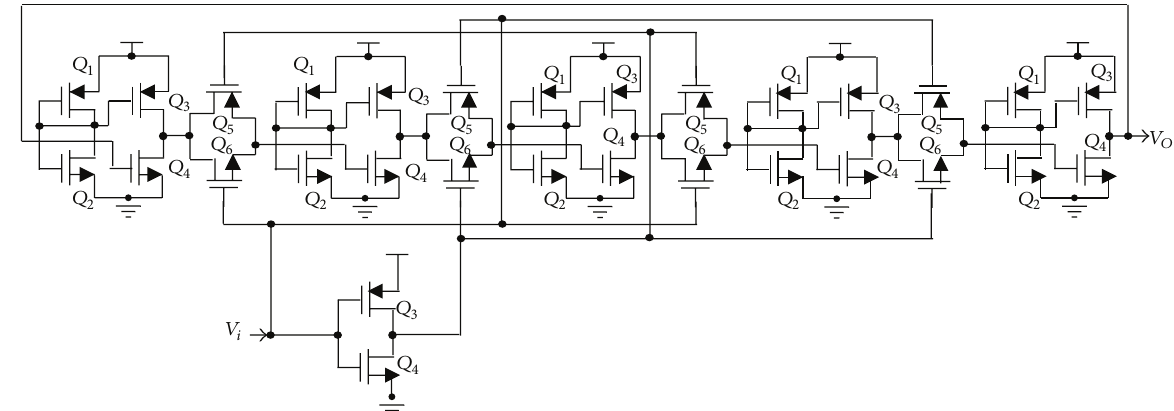
Figure 3: Device level presentation of Modified Current Source